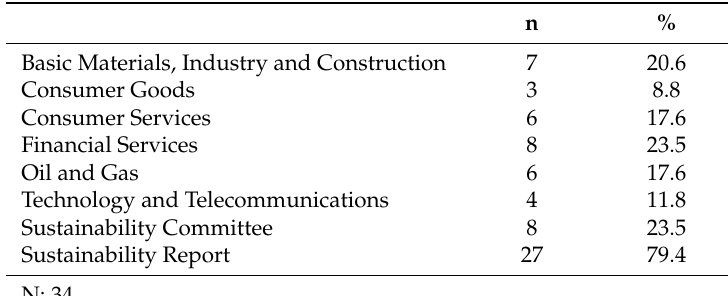
Table 5. Descriptive statistics—Dummy